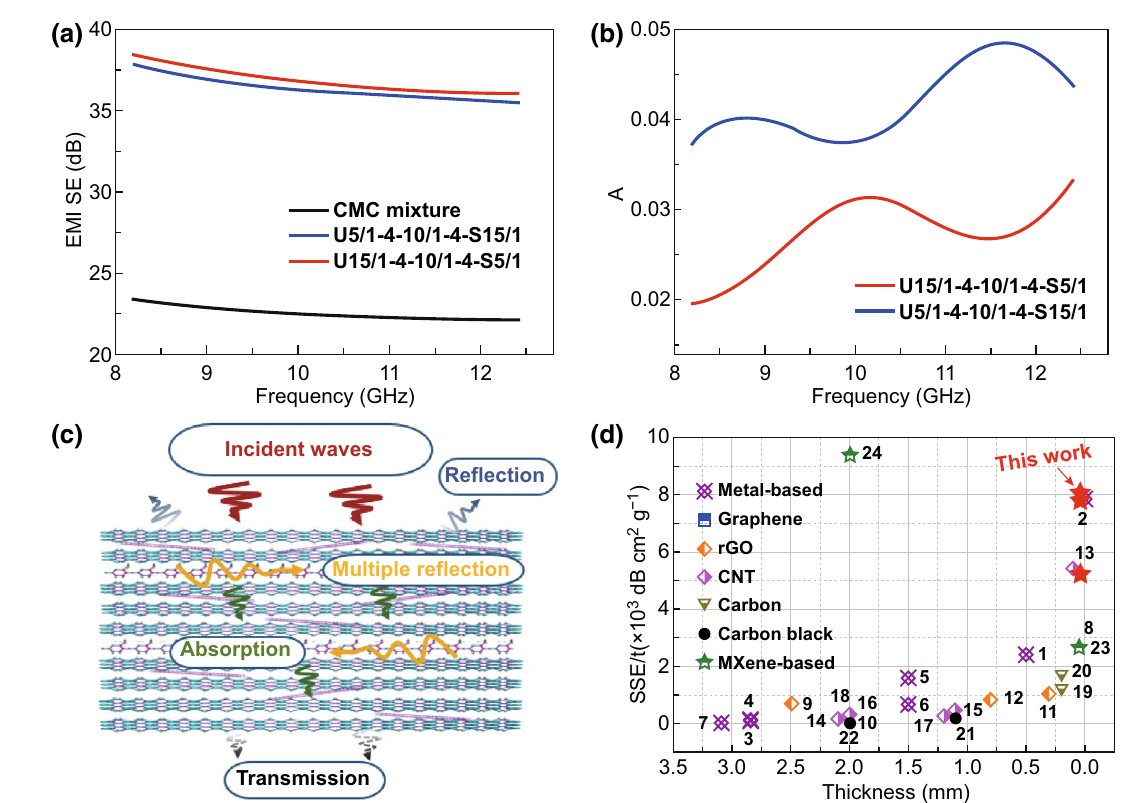
Fig. 6 a EMI SE of randomly mixed CMC paper and CMC GS composite paper in the X‑band. b The A of CMC GS composite paper with dif‑ ferent gradient structures. c Proposed EMI shielding mechanism of the CMC GS composite paper. d Comparison of the specific EMI shielding effectiveness as a function of thickness. The numbers inside d are sample numbers listed in Table